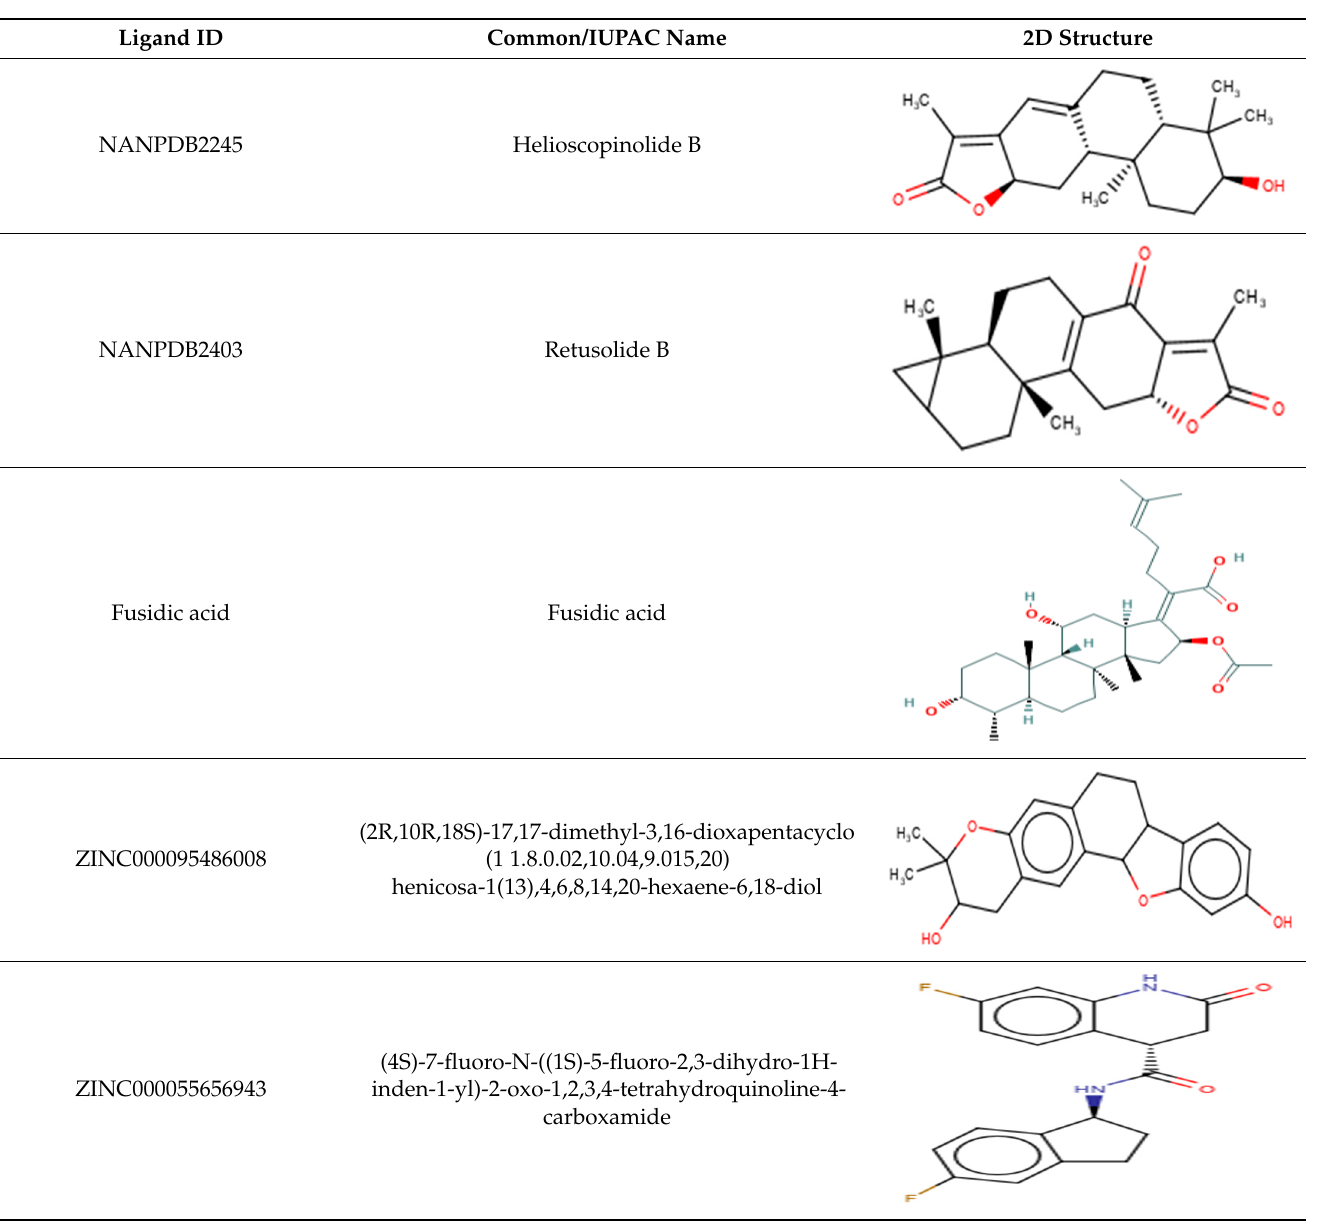
Table 6. A list of selected compounds with their 2D structures and common/IUPAC names generated using the Marvin suite (http://www.chemaxon.com/).